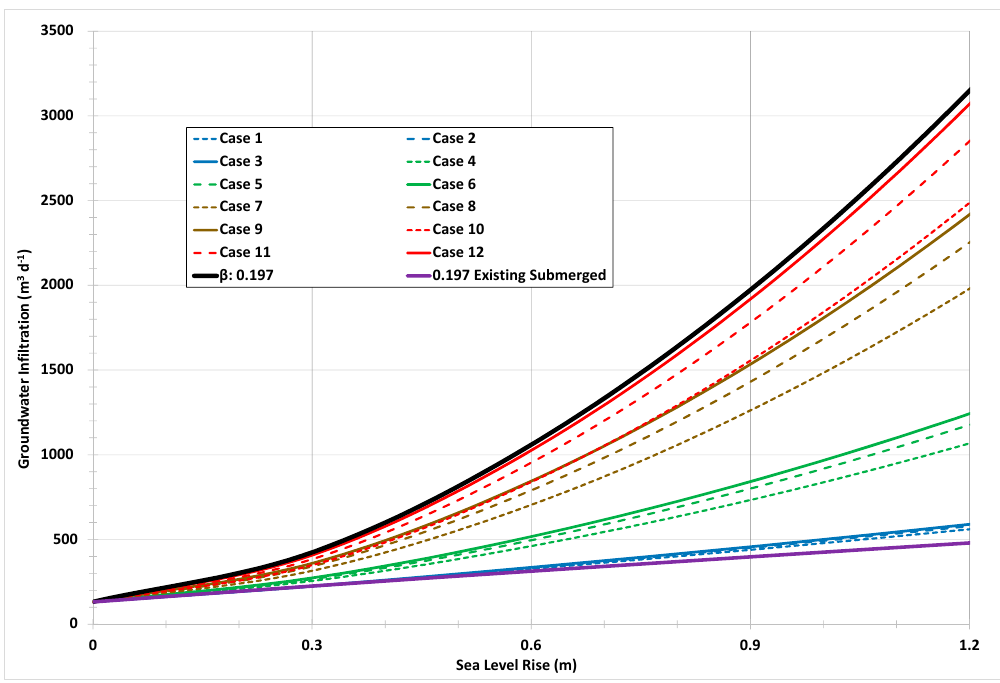
Figure 4. Defect severity matrix cases for SLR impact on GWI into sewer lines submerged in the future. 275